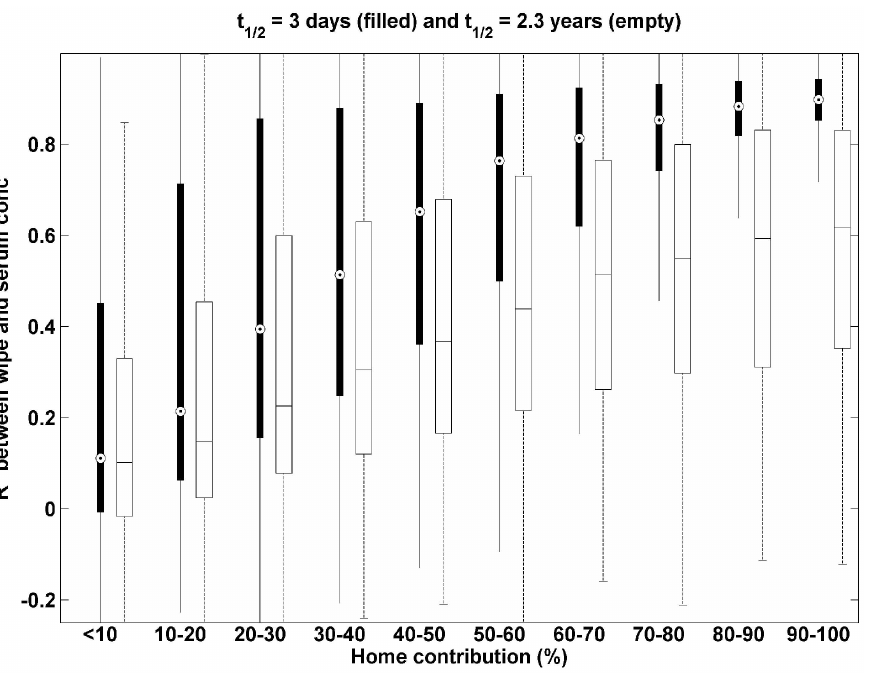
Figure 1. R 2 between wipe and serum concentrations with different contribution of home exposure for two compounds with 3 days of half-life (filled) and 2.3 years of half-life (empty).